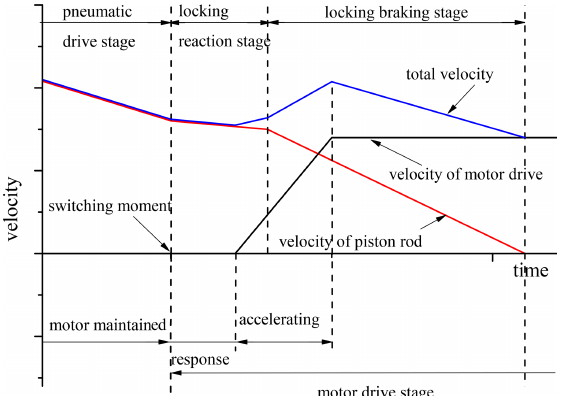
Figure 12. Braking resistance–initial velocity curve.